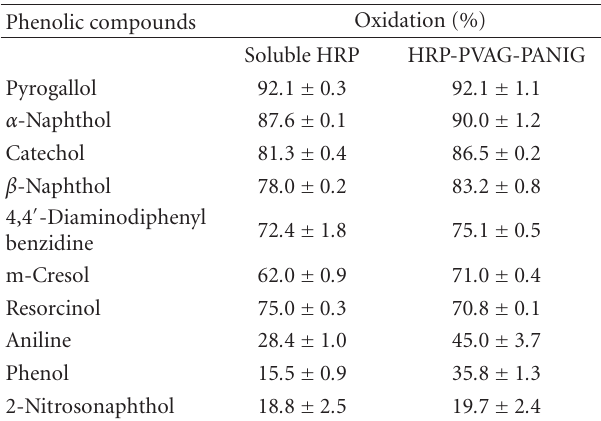
Table 1: Phenolic compounds oxidation by the soluble and HRP-